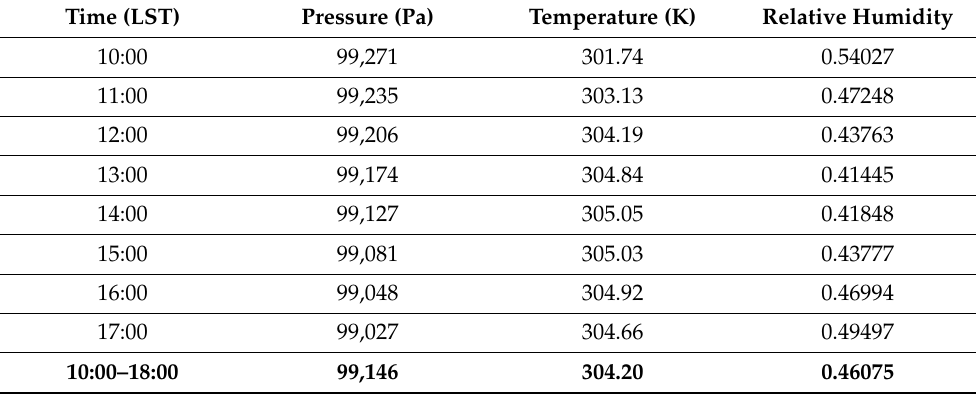
Table 1. Meteorological parameters for an 8-h time period on 29 June 2018. Average values of the meteorological parameters over the 8-h period are bolded, along with the corresponding time span to distinguish them from hourly values.